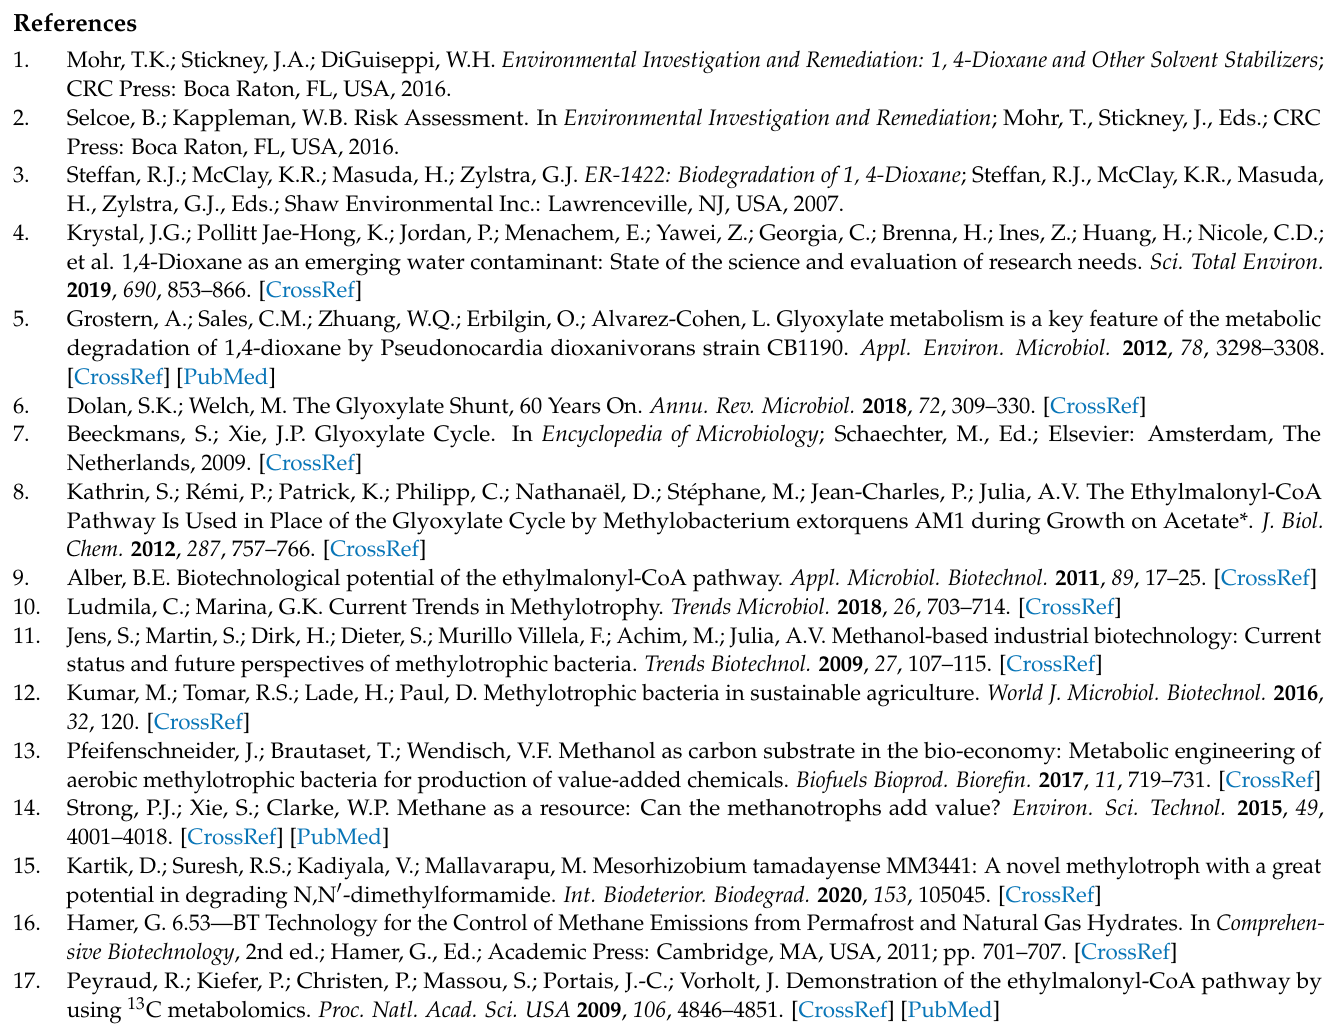
Table S6: Expression of Genes encoding two-component system, Table S7: Expression of genes related to chemotaxis, Table S8: DEGs with FPKM higher than